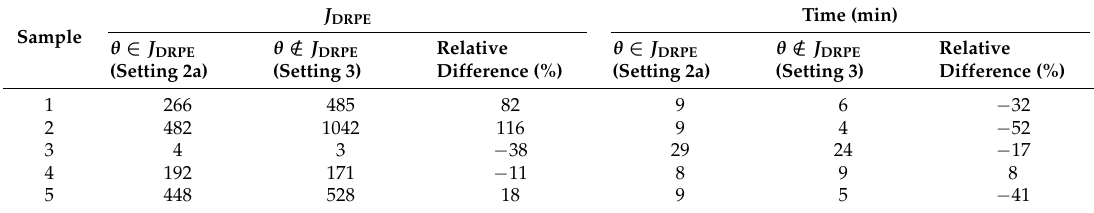
Table 10. Objective function values and computational cost as a function of problem formulation.